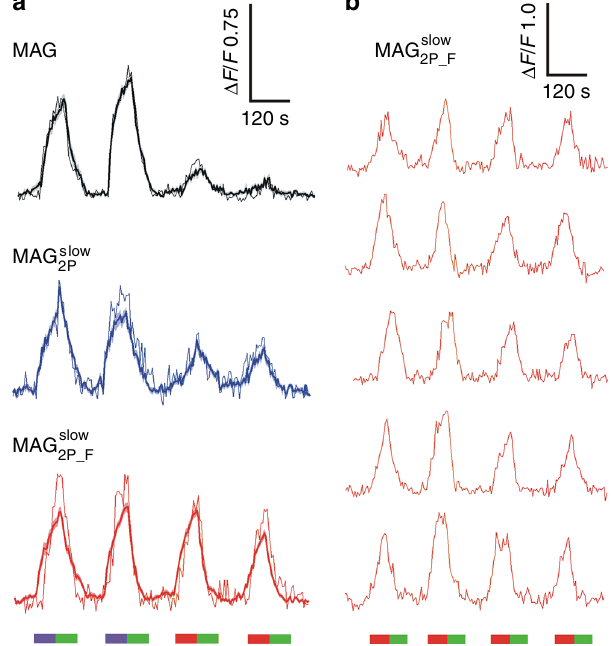
Fig. 4 One-photon (1P) and two-photon (2P) stimulation of MAG , , and MAG slow in cultured cells. a Individual (thin lines) and MAG slow 2P 2P (cid:1) F average (thick lines) calcium imaging fl uorescence traces recorded for human embryonic kidney 293 (HEK293) cells co-expressing GluK2-L439C and R-GECO1 after conjugation to MAG ( n = 16 biologically independent cells), MAG slow ( n = 14 biologically independent cells), and MAG slow ( n = 2P 2P (cid:1) F 34 biologically independent cells). The bands around average traces plot the corresponding SEM. Both 1P (violet, 405 nm, power density = 0.37 mW μ m − 2 ) and 2P excitation scans (red, 780 nm, power density = 2.8 mW μ m − 2 ) were applied to open LiGluR channels and trigger calcium- induced R-GECO1 fl uorescence enhancement, while 1P excitation scans (green, 514 nm, power density = 0.35 mW μ m − 2 ) were applied to revert back the process. b Repetitive 2P-induced calcium imaging fl uorescence responses recorded in fi ve different HEK293 cells co-expressing GluK2- L439C and R-GECO1 after conjugation to MAG slow . Source data for a are 2P (cid:1) F provided as a source Data fi